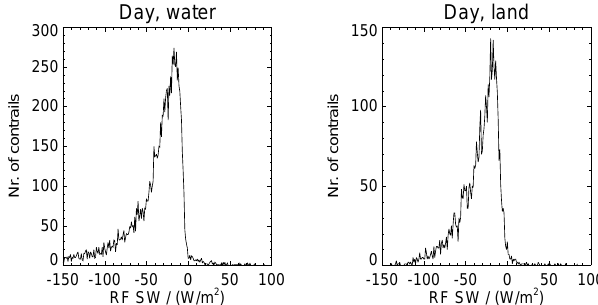
Figure 10. Frequency of occurrence of daytime SW RF for the tracked contrails. Nighttime SW RF (not shown) is